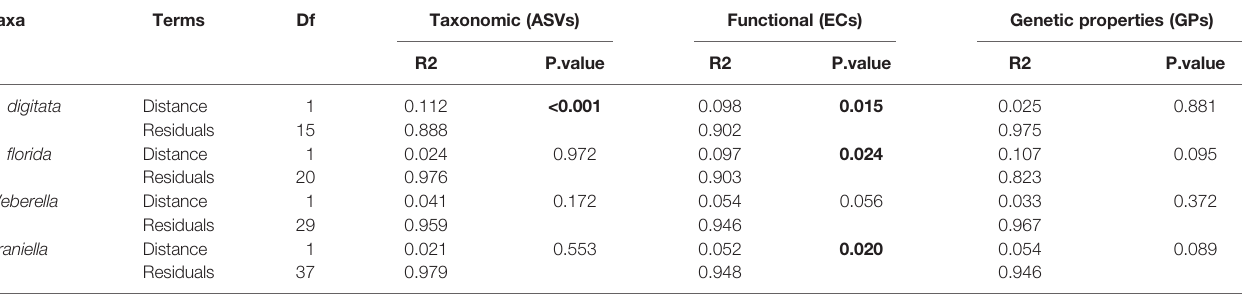
TABLE 4 | Permutational analysis of variance (PERMANOVA) of microbiome taxonomic and functional beta-diversity per epibenthic species across the fourth root transformed distance from farm.